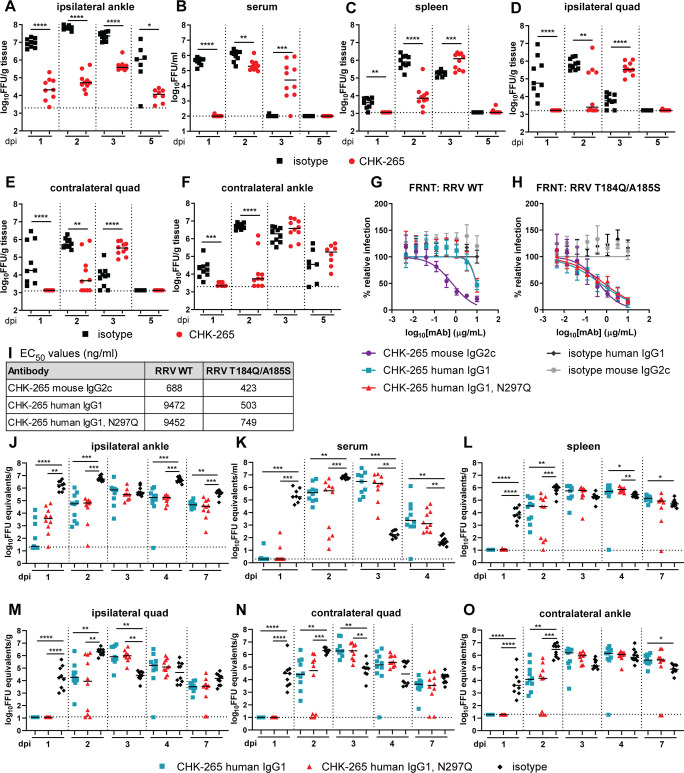
CHK-265 shifts the kinetics of RRV infection and dissemination independently of Fc effector interactions.Four-week-old male and female WT C57BL/6 mice were administered 100 μg of CHK-265 one day before infection with 103 FFU of RRV. (A) Ipsilateral ankle, (B) serum, (C) spleen, (D) ipsilateral and (E) contralateral quadriceps muscles (quad), and (F) contralateral ankle were harvested at indicated time points, and viral titers were determined by focus-forming assay [FFA (n = 7–10 per group; two experiments)]. Bars indicate median values (Mann-Whitney test at each time point for each tissue; *P < 0.05, **P < 0.01, ***P < 0.001, ****P < 0.0001). (G-H) Neutralization assays. mAbs (CHK-265 mouse IgG2c, CHK-265 human IgG1, or CHK-265 human IgG1 N297Q) were preincubated with 102 FFU of (G) RRV WT or (H) RRV T184Q/A185S and then added to Vero cells for 20 h. Viral foci were counted and compared to wells without mAbs to determine relative infection. WNV E16 human IgG1 and WNV E60 mouse IgG2c were included as isotype control mAbs. Graphs show mean values ± SD (three experiments performed in duplicate). (I) Non-linear regression constraining the top and bottom to 100 and 0, respectively, was used to determine the EC50 values of each mAb for each virus. Mean EC50 values are shown (three experiments). (J-O) Four-week-old male and female WT C57BL/6 mice were treated with 50 μg of CHK-265 human IgG1 or CHK-265 human IgG1 N297Q one day prior to inoculation with 103 FFU of RRV T184Q/A185S. (J) Ipsilateral ankle, (K) serum, (L) spleen, (M) ipsilateral and (N) contralateral quadriceps muscles (quad), and (O) contralateral ankle were harvested at indicated time points, and viral titers were determined by qRT-PCR (n = 9–10 per group; two experiments). Bars indicate median values (Kruskal-Wallis with Dunn’s post-test at each time point for each tissue; *P < 0.05, **P < 0.01, ***P < 0.001, ****P < 0.0001).